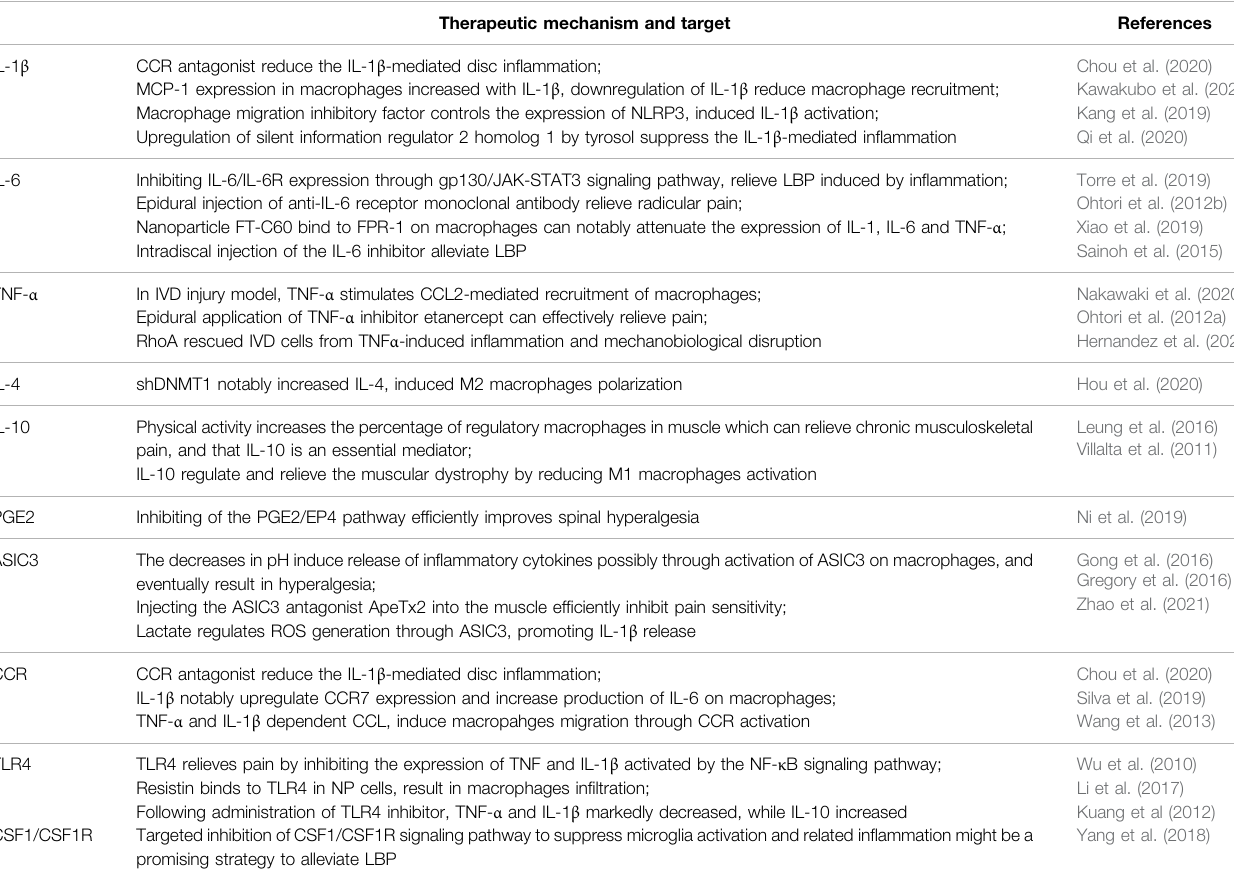
TABLE 2 | Molecular targets related to treatment of LBP by regulating macrophages-mediated in fl